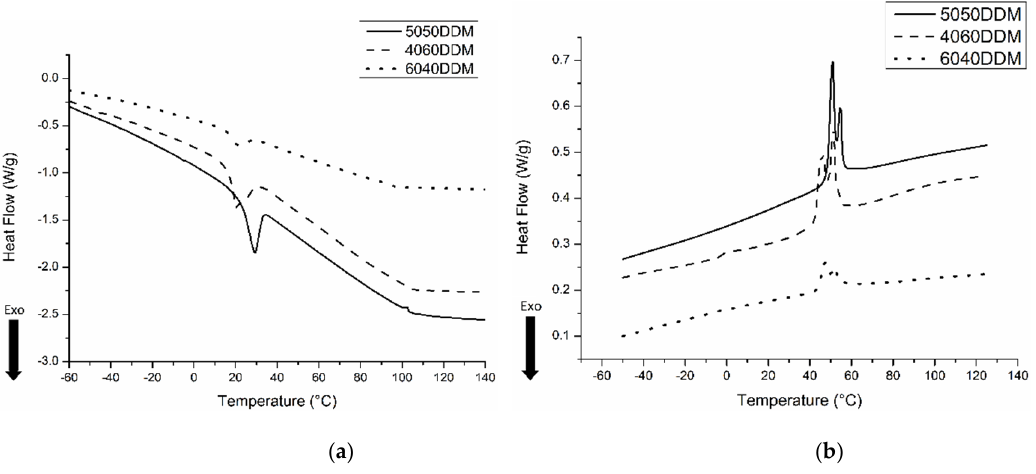
Figure 5. ( a ) DSC cooling scans for different composition of DGEBA/PCL blends, cured with DDM for 16 h; and ( b ) subsequent heating scans after the cooling run shown in ( a ).